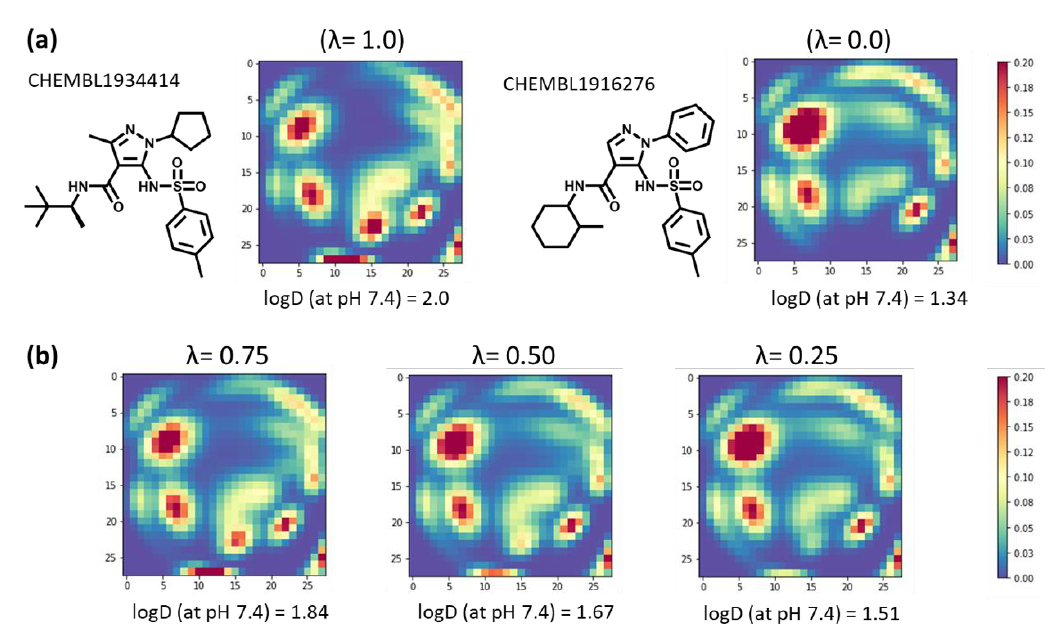
Figure 8. Data augmentation using mixup. λ is the mixing coefficient for both images (MTMs) and their labels (logD (at PH 7.4)). ( a ) Chemical structures and MTMs of CHEMBL1934414 and CHEMBL1916276, respectively. The compound